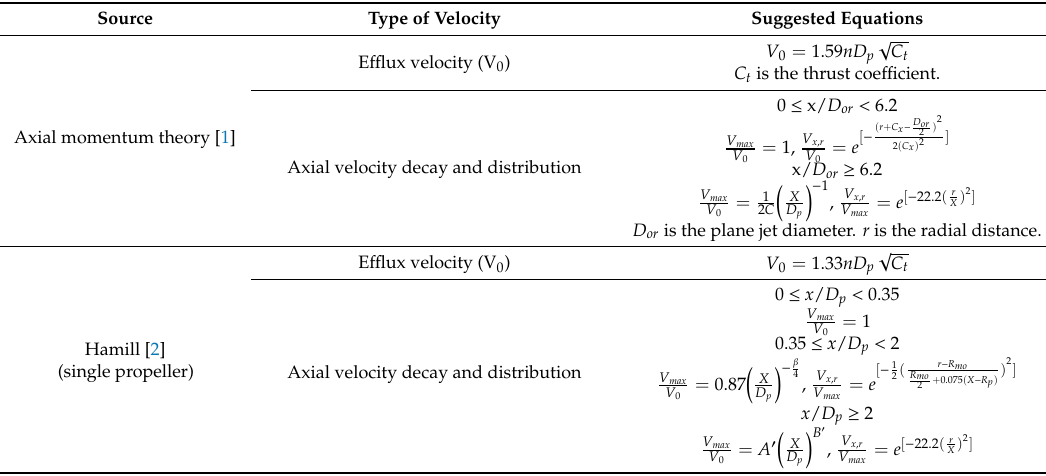
Table A1. Summary of propeller jet velocity